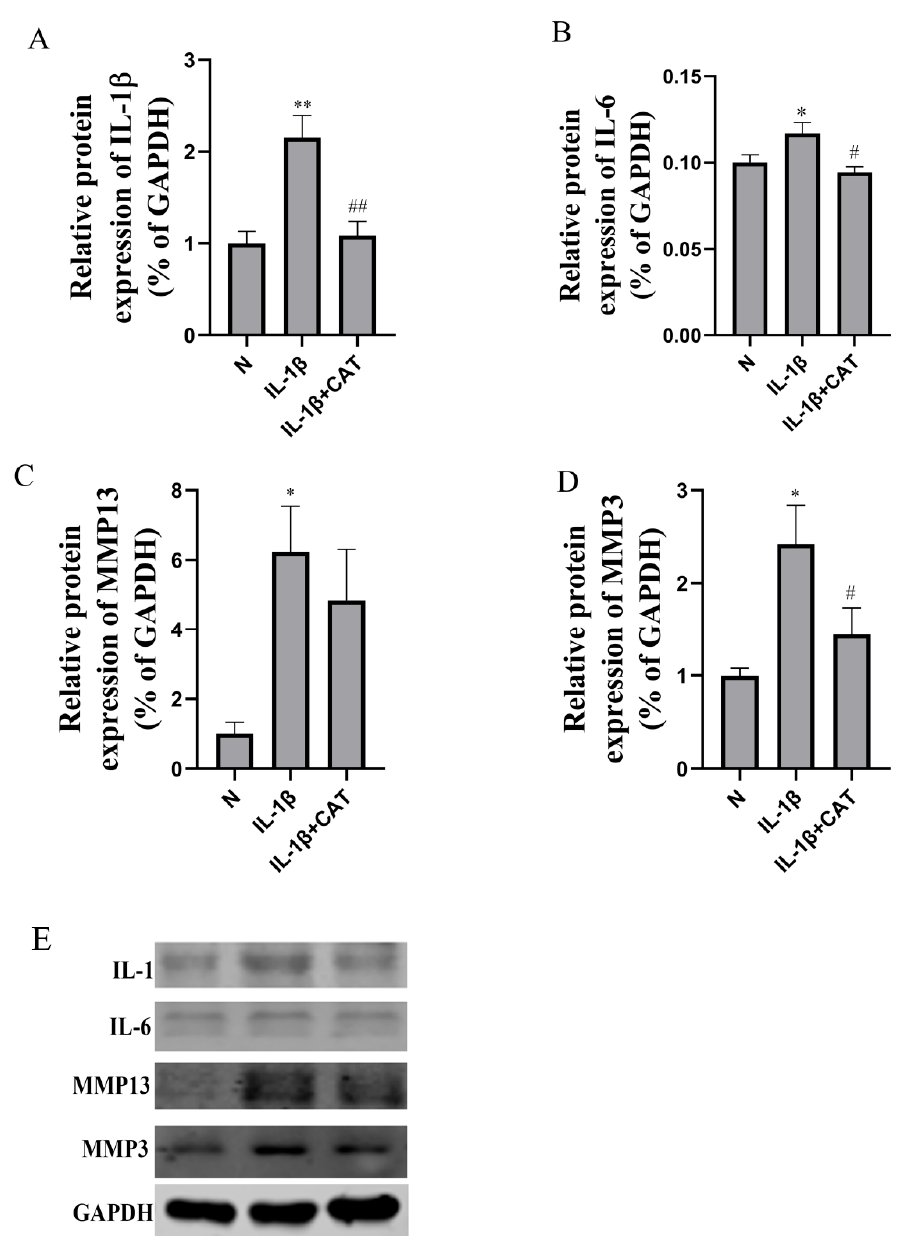
Figure 6. Western blot analysis of inflammasome activation-associated proteins expression in chon- drocytes. ( A ) IL-1 protein level; ( B ) IL-6 protein level; ( C ) caspase-3 protein level; ( D ) MMP13 pro- tein level; ( E ) MMP3 protein level. Above, densitometric analysis; below, representative images of immunoblots. The data are the mean ± S.D. of the mean (n = 3). * p < 0.05 vs. normal group (N); ** p < 0.01 vs. normal group (N); # p < 0.05 vs. IL-1 β group; ## p < 0.01 vs. IL-1 β group.